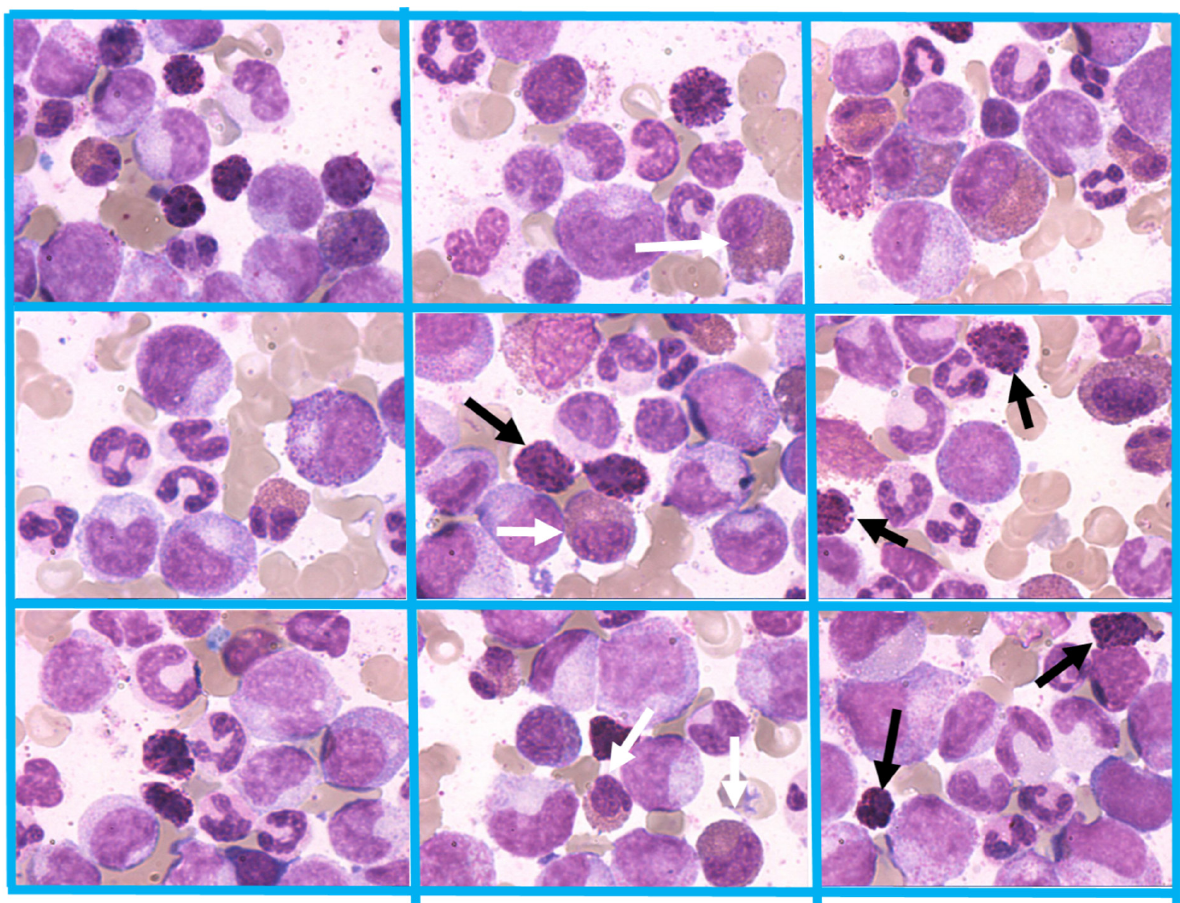
Figure 7. CML-CP presenting with characteristic hyperplasia of the granulocytic lineage with increased number of precursor cells (left-shifted granulopoiesis). In addition, typical immature basophils (black arrows) and immature eosinophils (white arrows) are present. Magnification 800×.